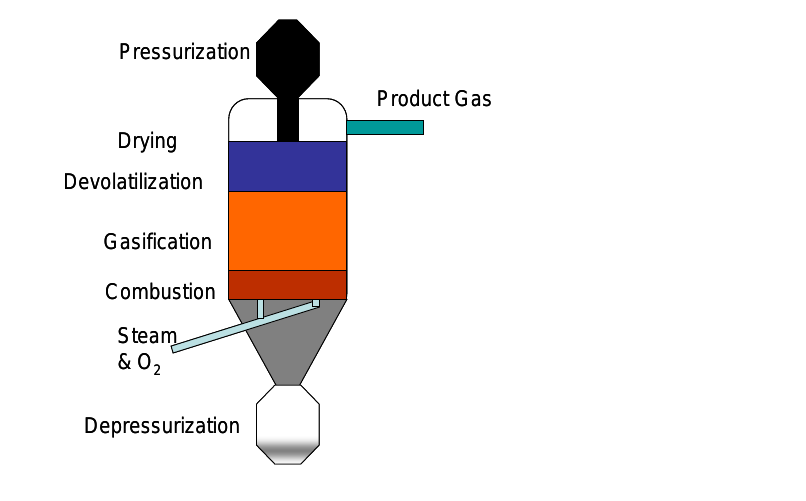
Figure 19. Typical Configuration for Dry and Slagging Moving Bed.